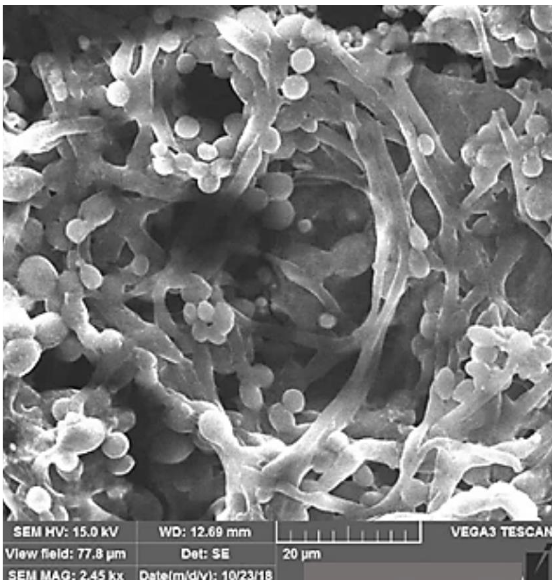
Figure 30. SEM images of graphene-oxide nanostructures using a 532 nm wavelength. [67]